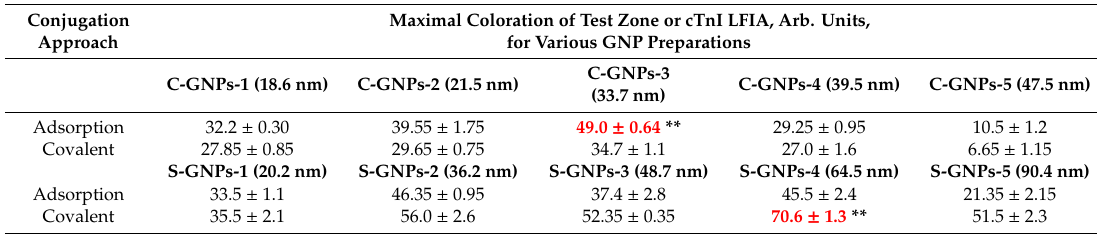
Table 7. Maximal coloration * of test zone for LFIAs of cTnI with di ff erent antibody–GNP conjugates. Conjugation